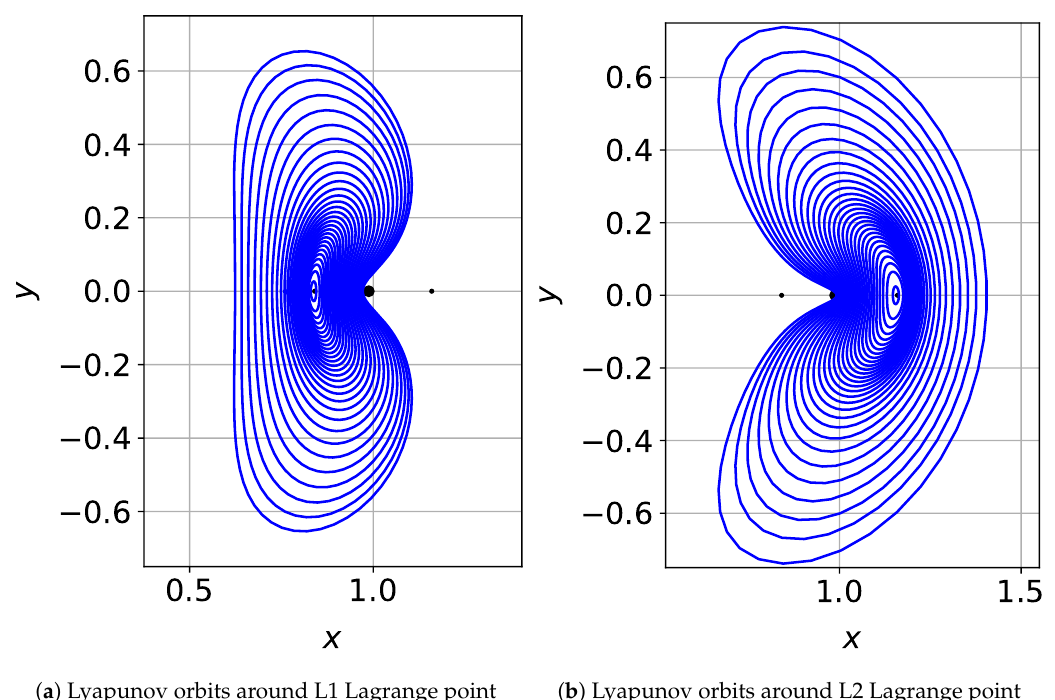
Figure 2. Trajectories of Lyapunov orbits for the Earth–Moon system ranging from energies close to the L1/L2 equilibrium points to